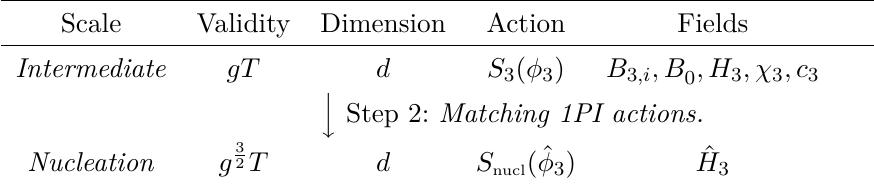
(ˆ φ 3 ). Here, we distinguish nucl